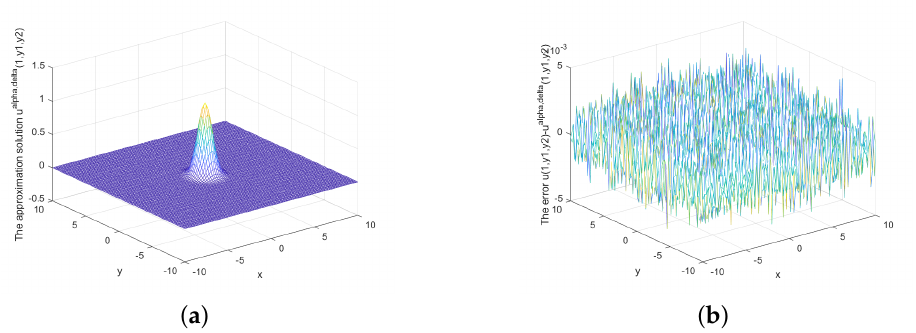
Figure 3. ( a ) The regularized solution and ( b ) error when x = 0.2, δ = 1 × 10 − 4 under prior rule.